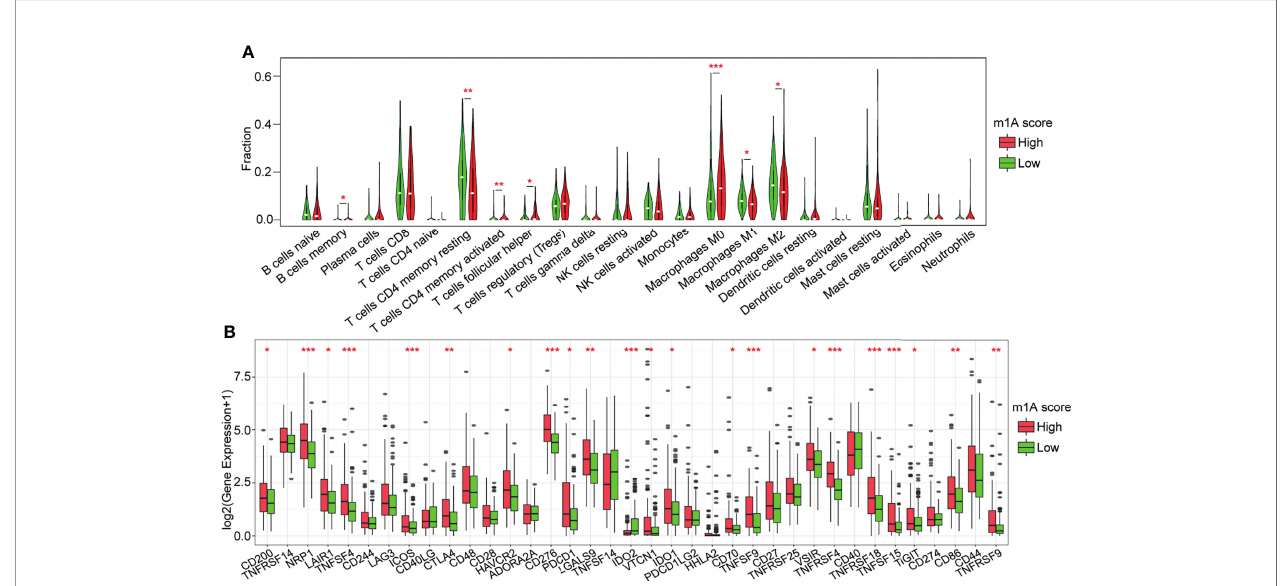
FIGURE 7 | Correlation analysis of immune regulation and the m1A score. (A) Distribution of 22 types of immune cells in the high- and low-m1A score groups. (B) Expression of 37 immune checkpoints in the high- and low-m1A score groups. *P < 0.05, **P < 0.01, ***P <